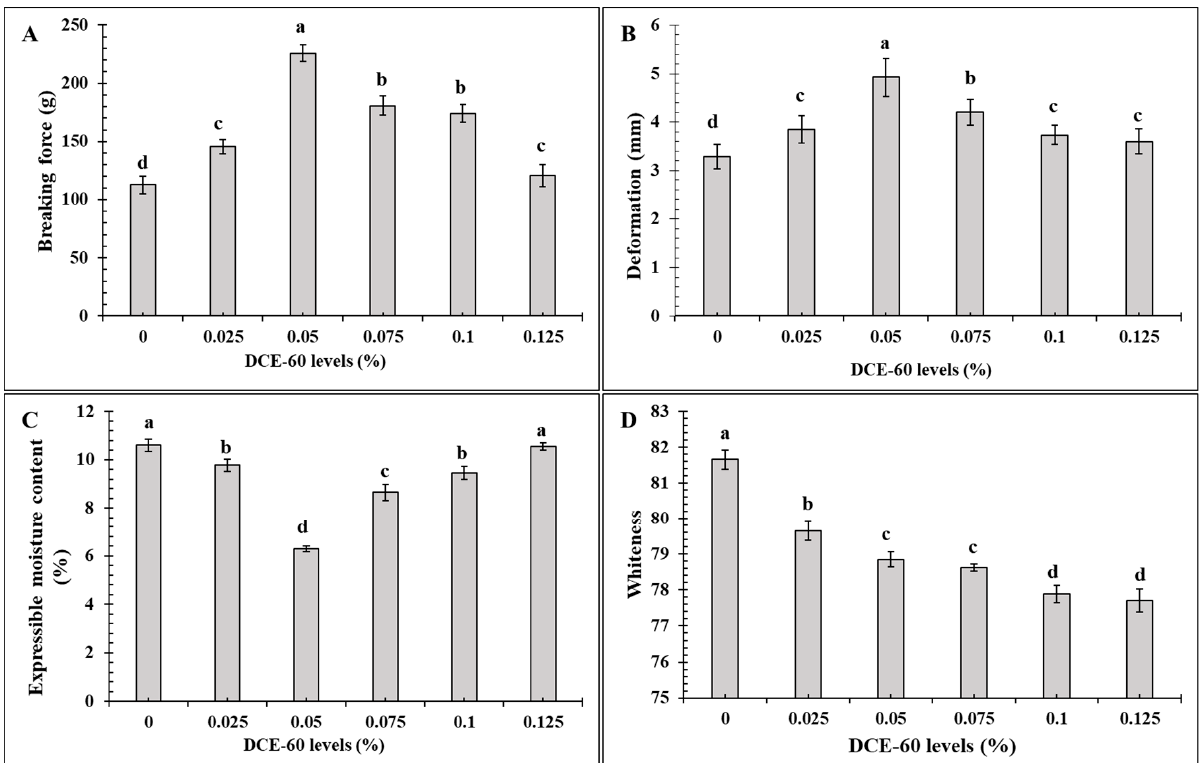
Figure 2. Breaking force ( A ), deformation ( B ), expressible moisture content ( C ) and whiteness ( D ) of the surimi gel added without and with DCE-60 at different levels. The bars represent the standard deviation ( n = 3). The different lowercase letters on the bar indicate significant differences ( p < 0.05). DCE-60: Duea ching extract prepared using 60% ( v/v ) ethanol.